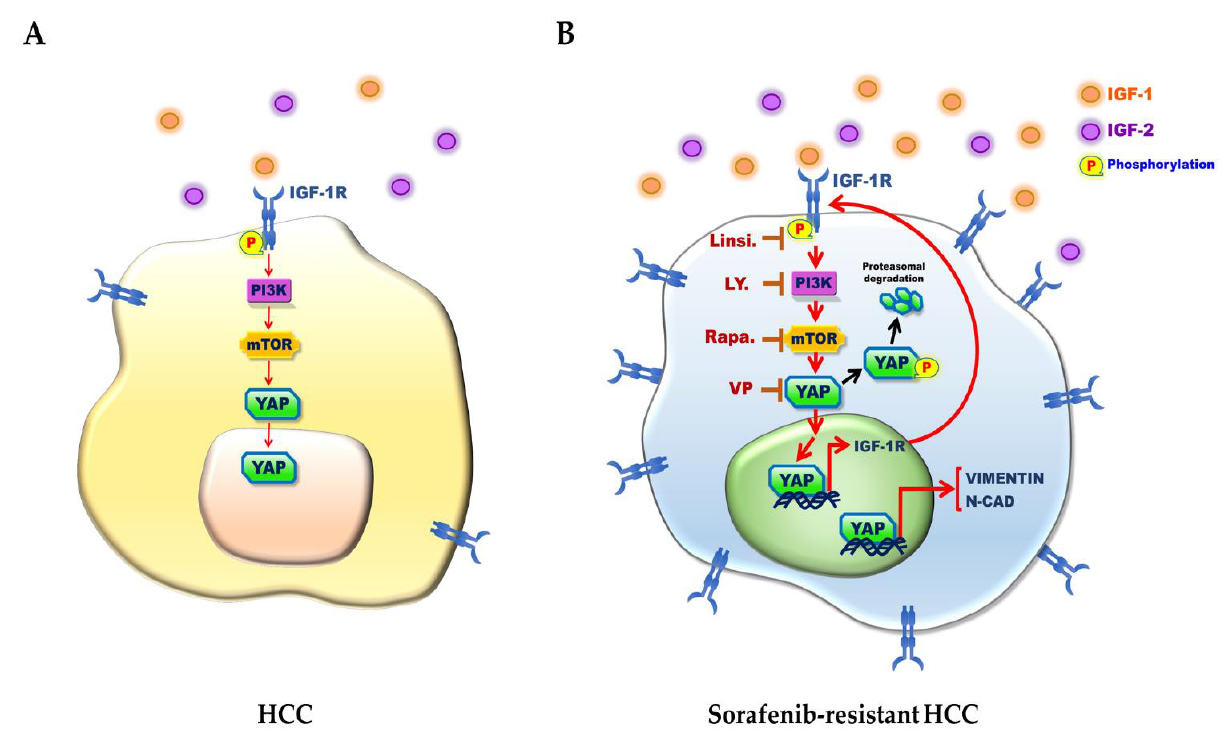
Figure 6. Schematic of the YAP/IGF-1R signaling loop involved in the sorafenib resistance and EMT property of HCC cells. ( A ) The naïve HCC cells show a lower expression level of YAP and IGF-1R. ( B ) The sorafenib-resistant HCC cells express higher levels of YAP and IGF-1R proteins. The IGF-1/2–IGF-1R signaling activation induces YAP nuclear translocation. YAP blockage by verteporfin (VP) reduces the expression levels of IGF-1R and EMT markers. The inhibition of IGF-1R signaling by small molecule inhibitors perturbs YAP nuclear translocation.